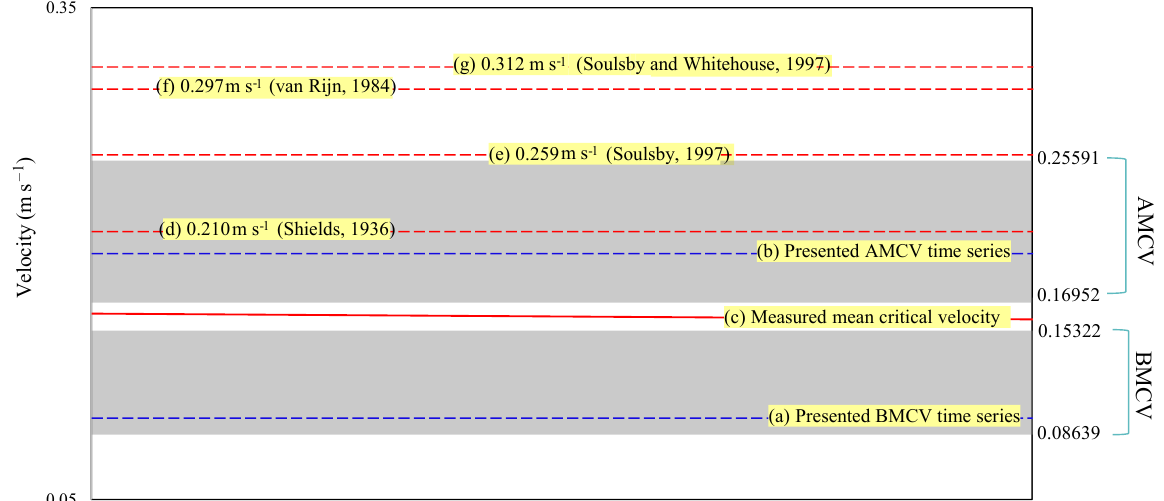
compared to the other two events (Fig. 6). Previously, per- formance of quadrant analysis by Heathershaw and